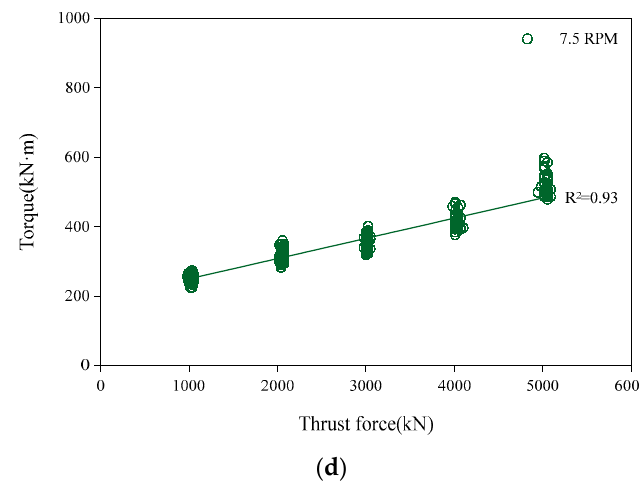
Figure 8. Relationships between thrust force and torque at different RPM levels of cutterhead, ( a ) At 1.5 RPM; ( b ) At 4.5 RPM; ( c ) At 6.0 RPM ; ( d ) At 7.5 RPM. Based on the test results, the regression lines obtained at 7.5 RPM level according to UCS of rock mass are shown in Figure 9. On the application of constant thrust force, greater penetration depth was observed at low UCS which resulted in higher torque development. It is thus deduced that the relationships between thrust force and torque are a ff ected by UCS more significantly as compared to the rotational speed of the cutterhead.